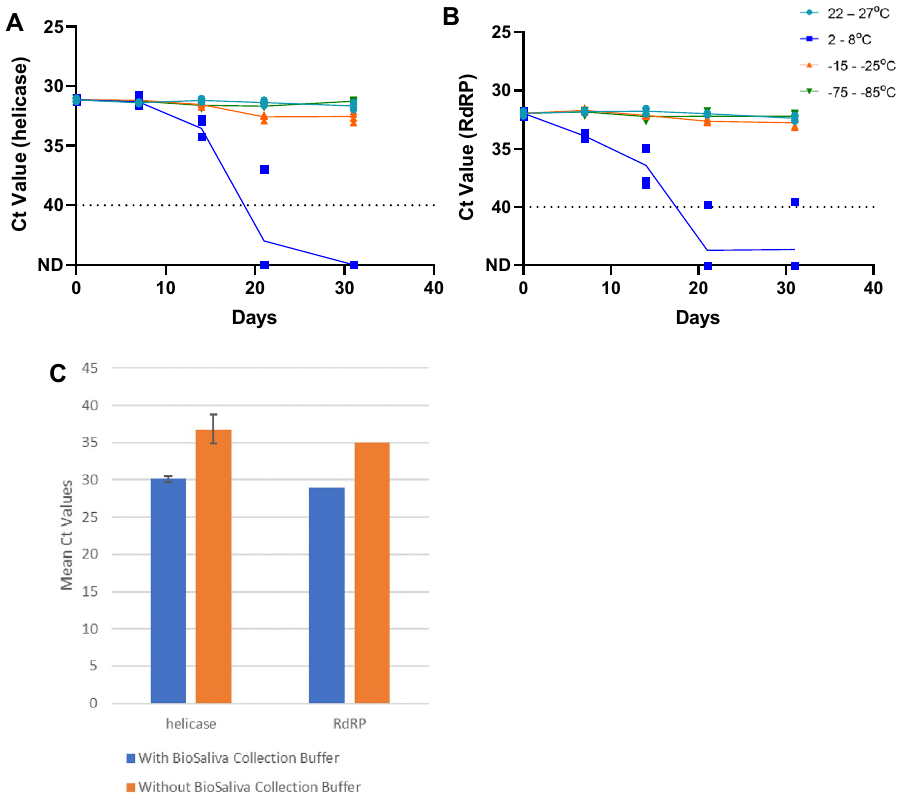
Figure 1. ( A ), (B) Stability of SARS-CoV-2 viral RNA at room temperature, 4 °C, − 20 °C, and − 80 °C for 31 days. Both target genes, helicase ( A ) and RdRP ( B ), were detected with no increase in Ct values at room temperature and − 80 °C, while no detection of SARS-CoV-2 viral RNA observed on samples stored at 4 °C. ( C ) Ct values comparison between spiked gargle specimens with and without BioSaliva Collection Buffer. Increased Ct value was observed on spiked gargle specimens without BioSaliva Collection